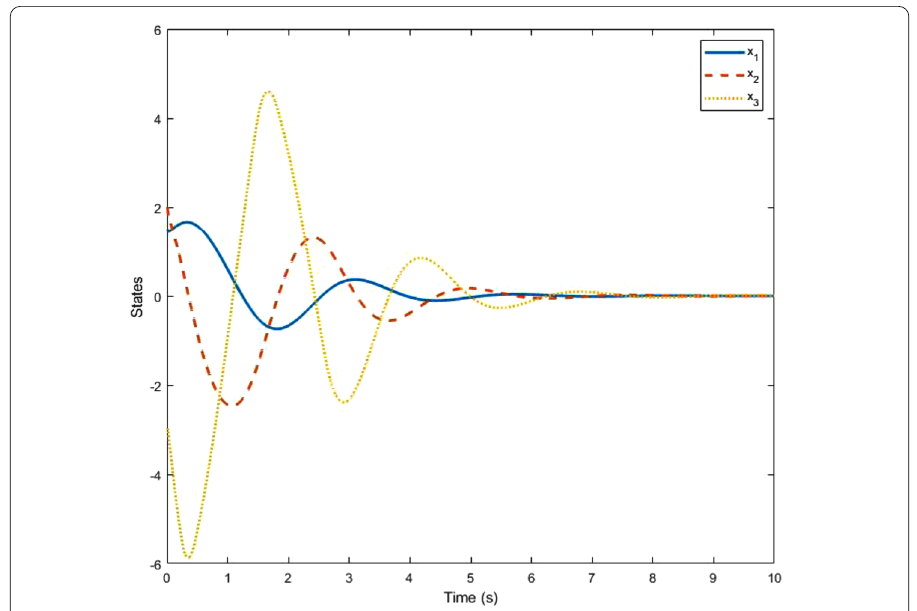
Figure 2 States of the Arneodo system with the proposed controller